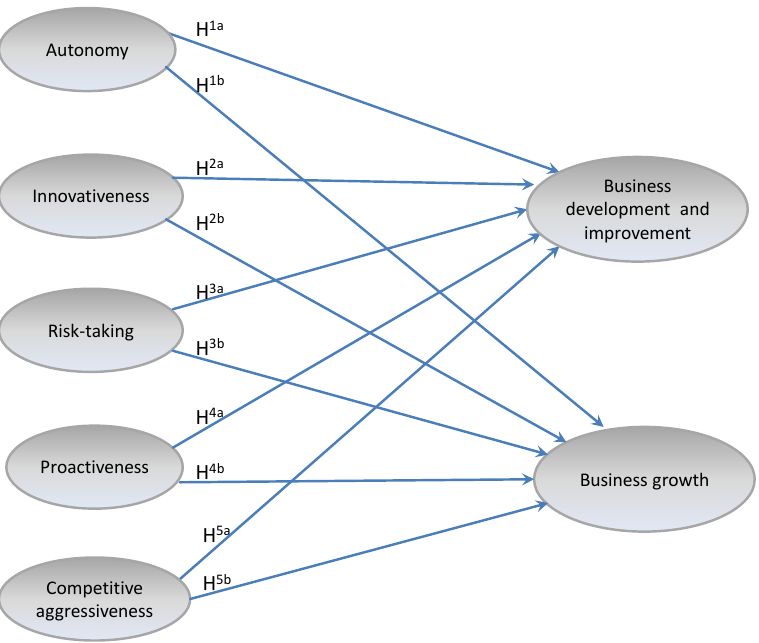
Figure 2: The modified hypothesised model